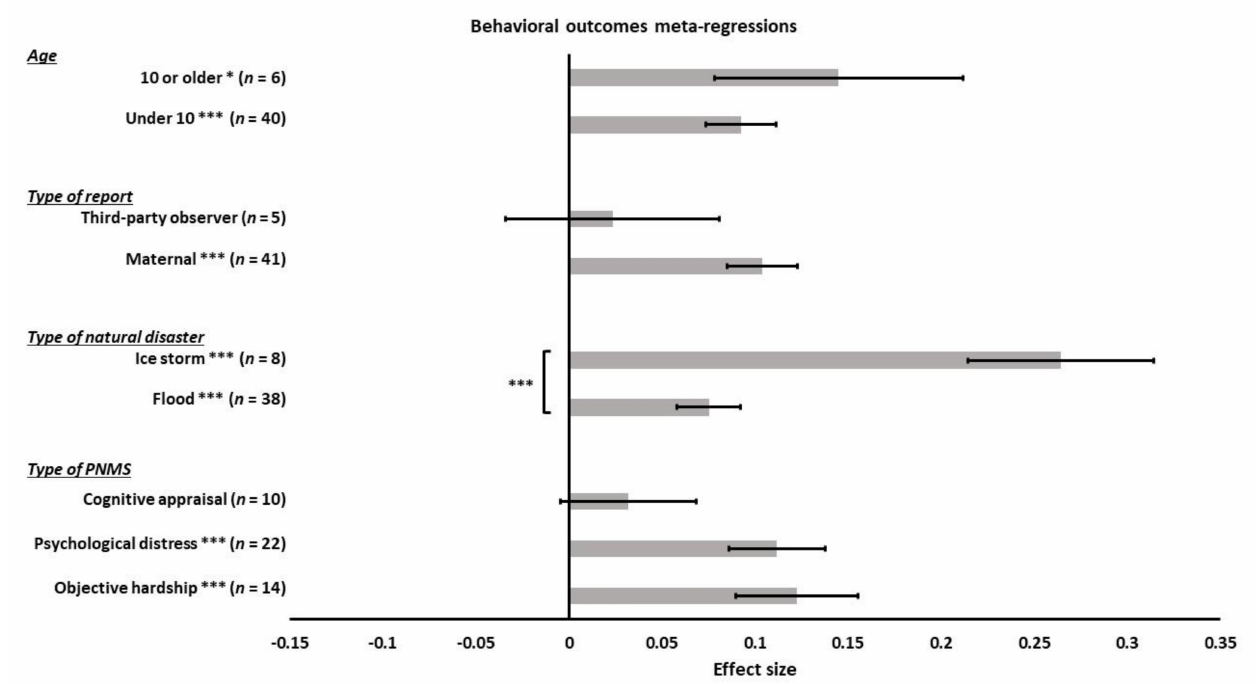
Figure 19. Behavioral outcomes meta-regressions. Type of PNMS effect (objective hardship; psychological distress; cognitive appraisal) on behavioral outcomes, type of natural disaster effect (flood; ice storm), type of report effect (maternal; third- party observer), and age effect (under 10 or 10 or older) on the association between PNMS levels and physical outcomes. Note: * p < 0.05; *** p <